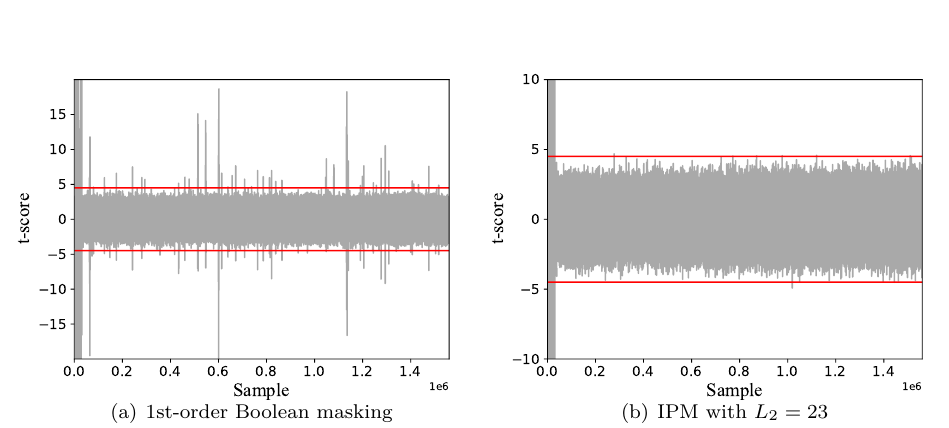
Figure 3: TVLA (t-test) results for BM1 (left) and IPM23 (right) with TRNG activated and sampling rate at 156 MHz. The red lines mark the ± 4 . 5